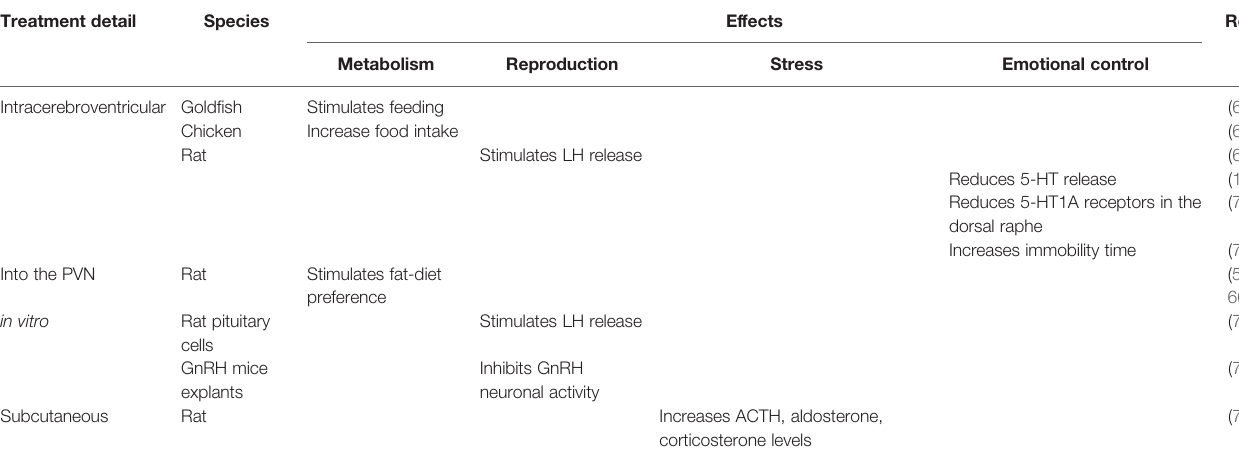
TABLE 6 | Summarised table of effects of various GAL